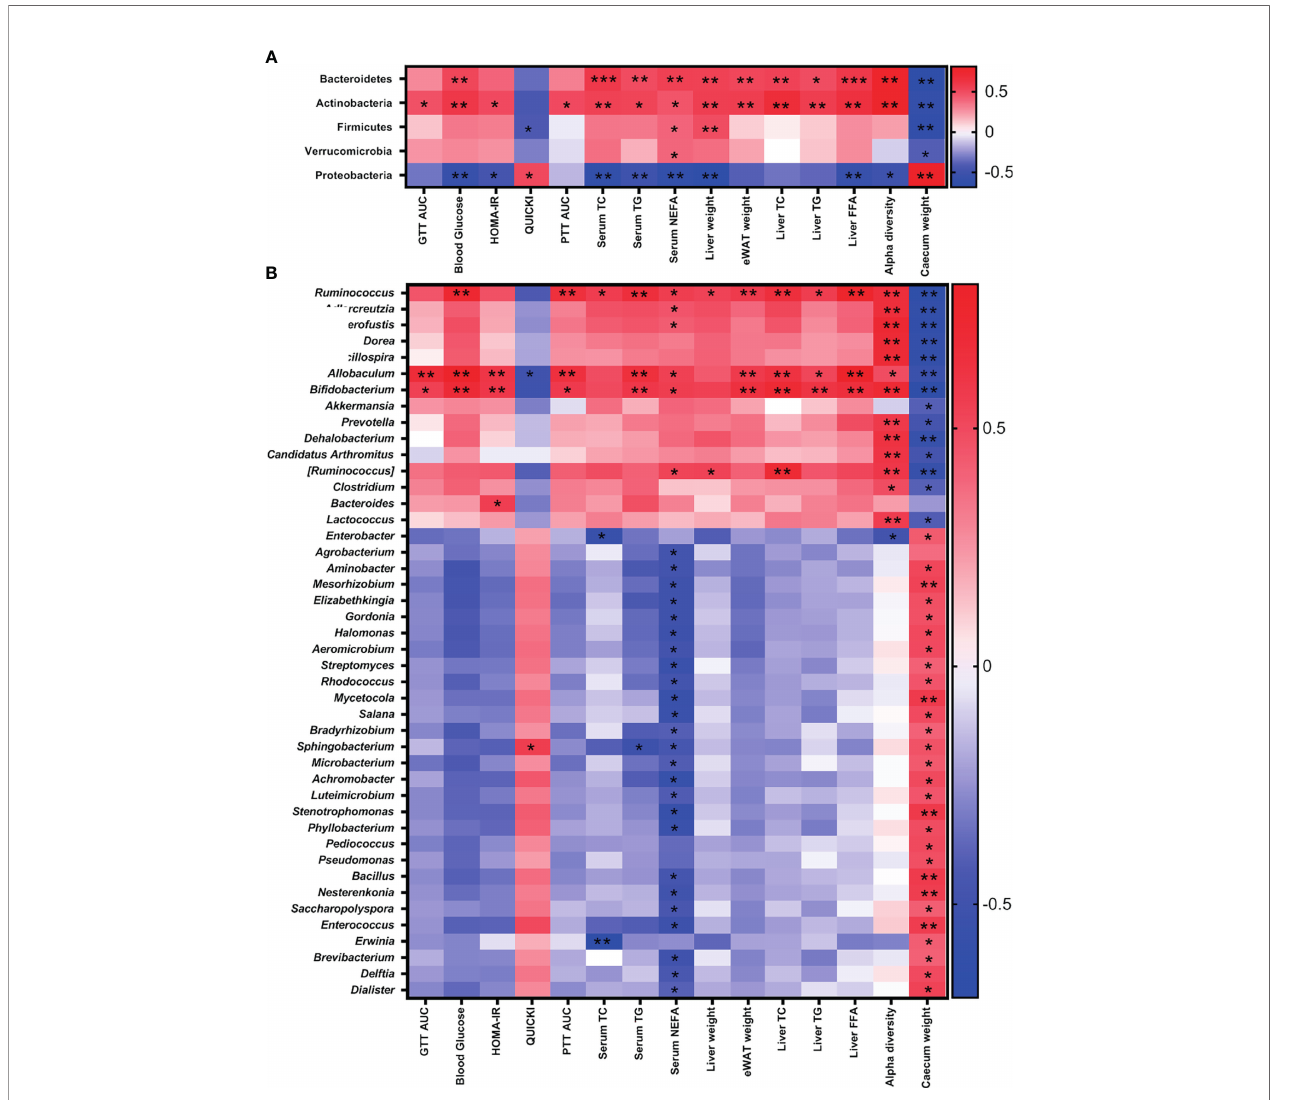
FIGURE 6 | Association of gut microbiota with metabolic parameters in iNOS − / − mice following treatment with antibiotics. Heatmap of Pearson ’ s correlation coef fi cients between changes in different metabolic parameters and microbial taxa at the (A) phylum and (B) genus levels caused by gut microbiota modulation by vancomycin and Abx in WT and iNOS − / − mice. * p < 0.05, ** p < 0.01, *** p < 0.001 represent signi fi cant correlations between metabolic biomarker and bacterial taxa. Blue color represents negative and red positive correlations. See also Figure S11